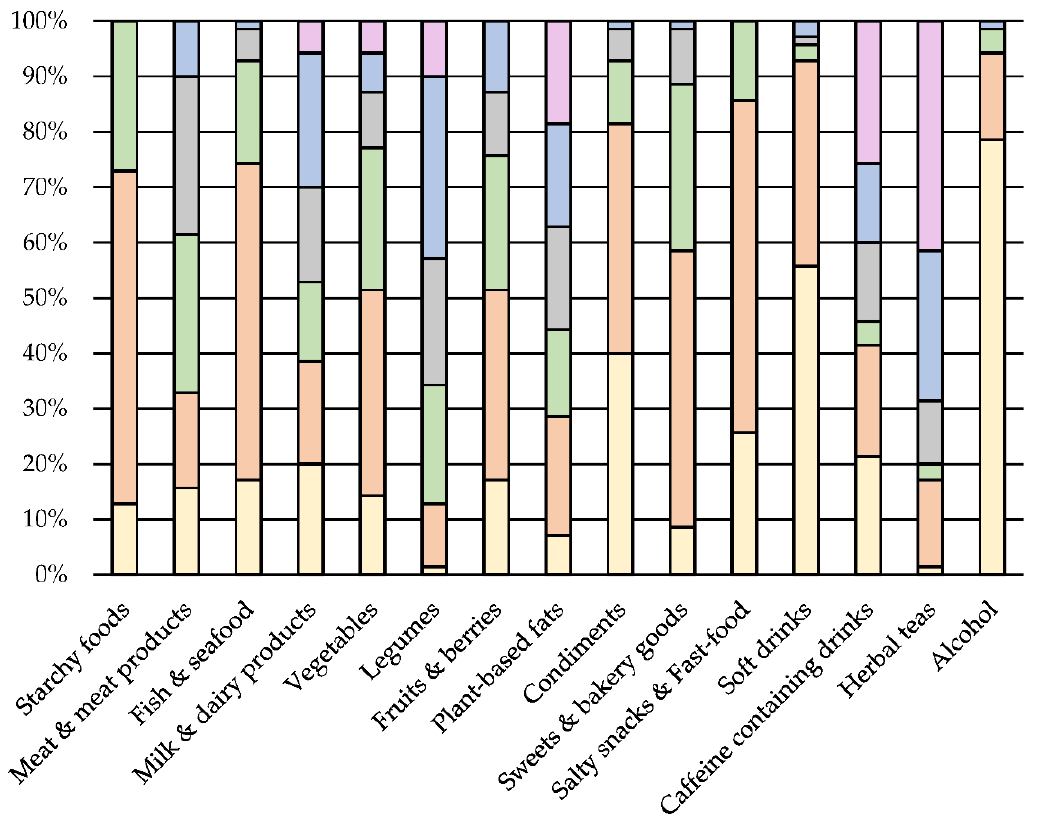
Figure 1. Median intake frequency of food products and drinks one month before participating in the study.